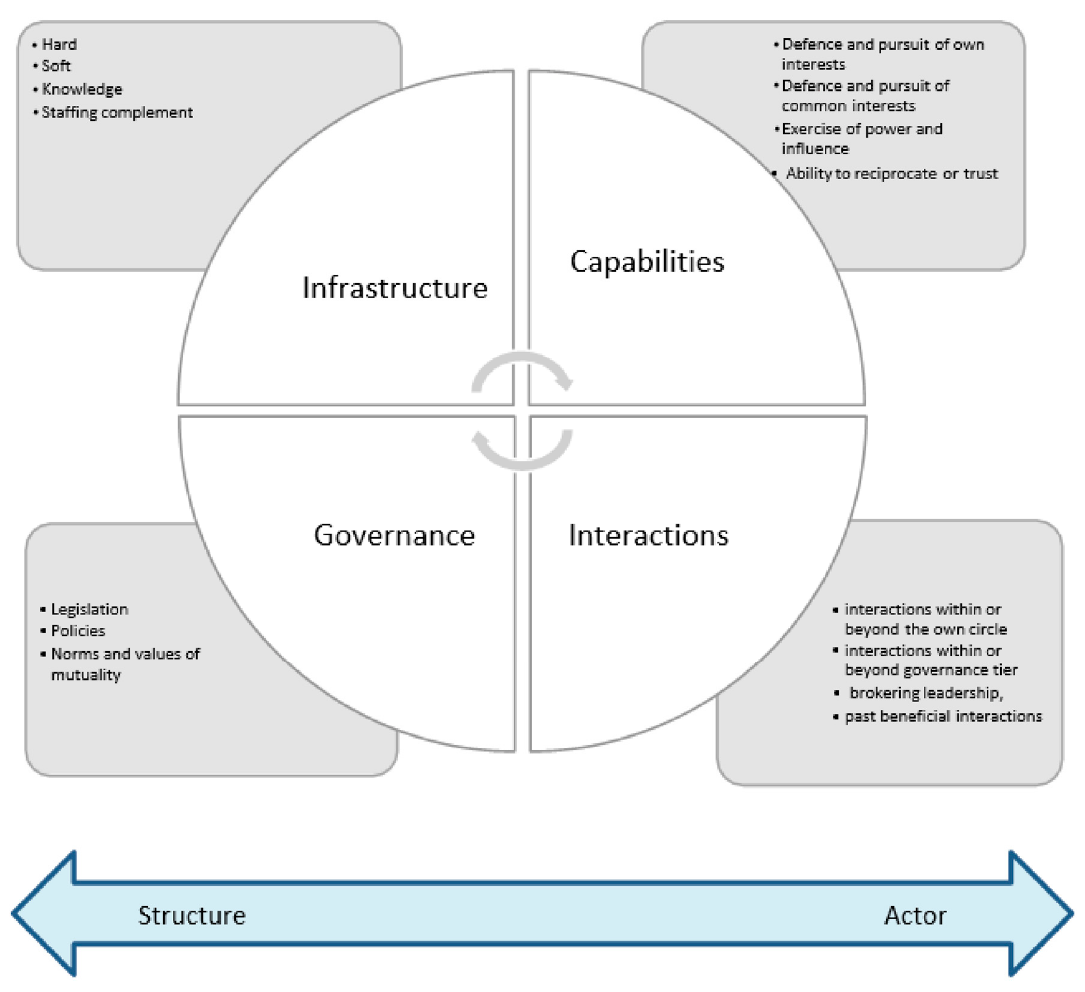
Figure 1. SI Framework for Collaborative